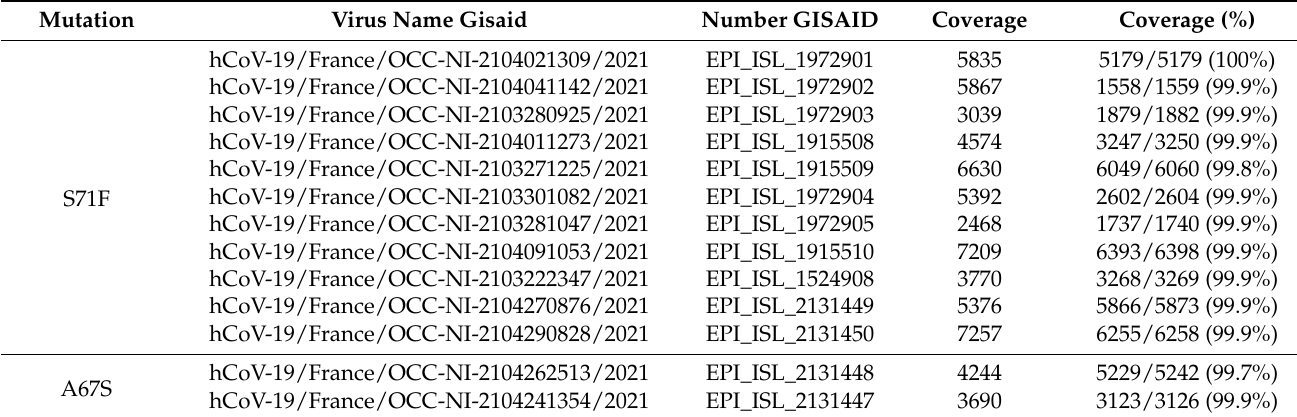
Table 1. Details of the characteristics of the NGS sequences deposited in GISAID (Global Initiative on Sharing All Influenza